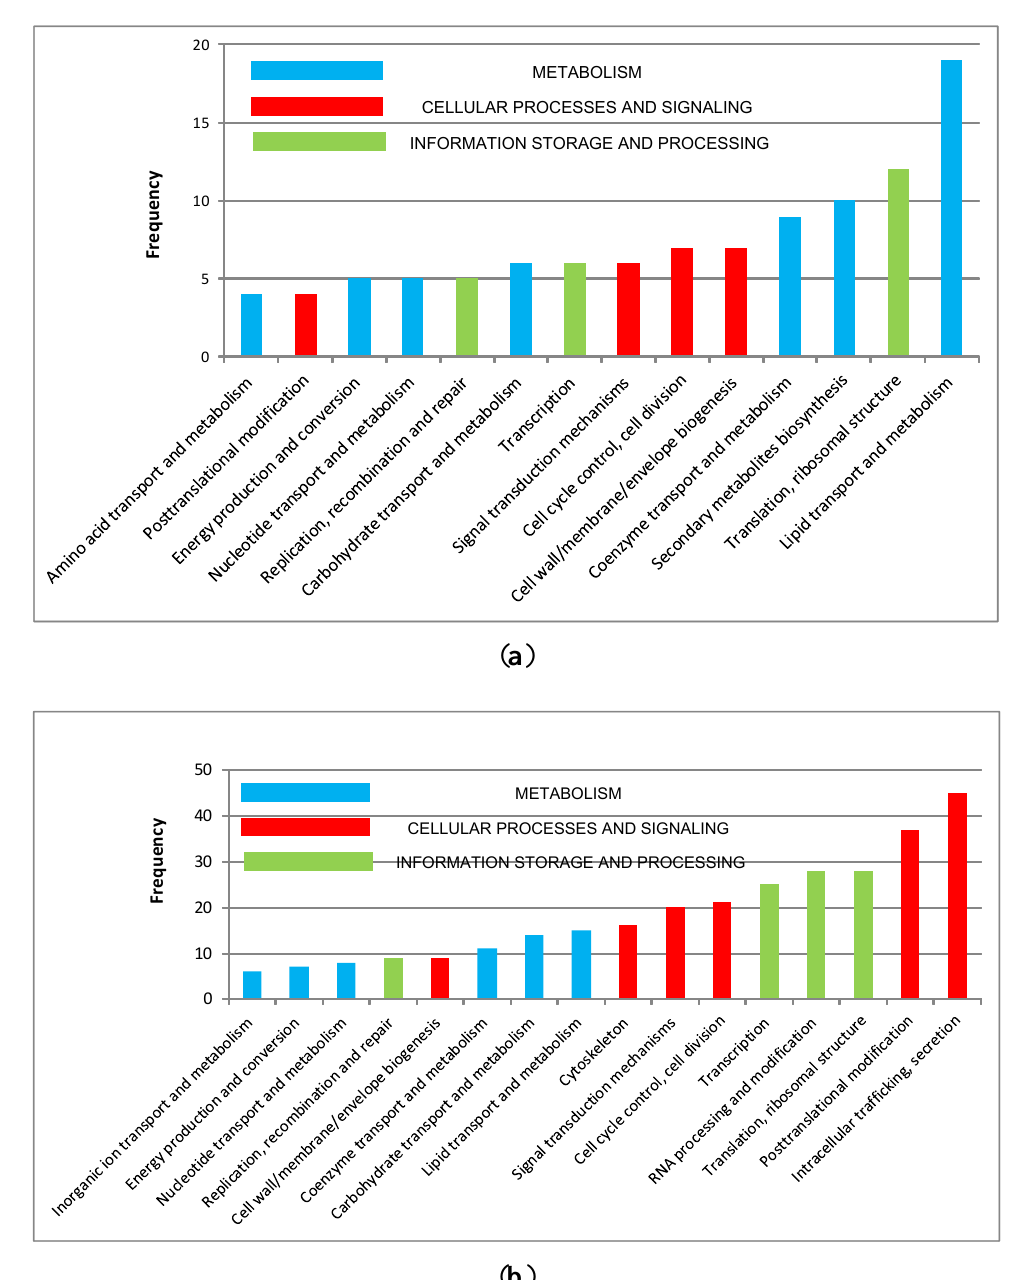
Figure S1. Functional distribution of false negative genes according to the orthologous groups of proteins (COGs) classification in EC ( a ) and SC ( b )